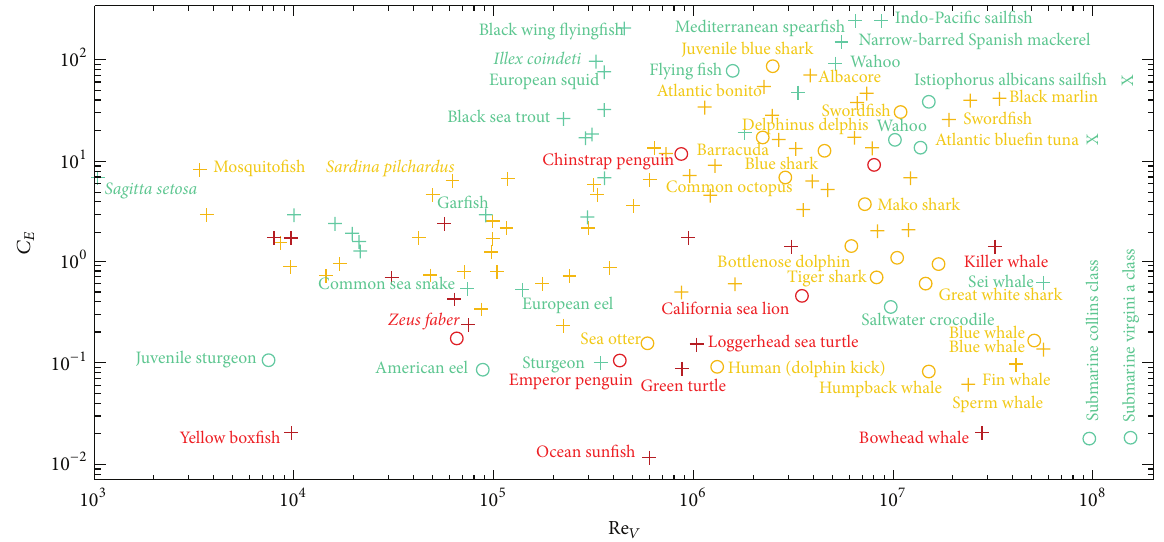
Figure 4: The capacity-efficiency factor 𝐶 𝐸 (W/kg) versus volumetric Reynolds number for different animals and vehicles.